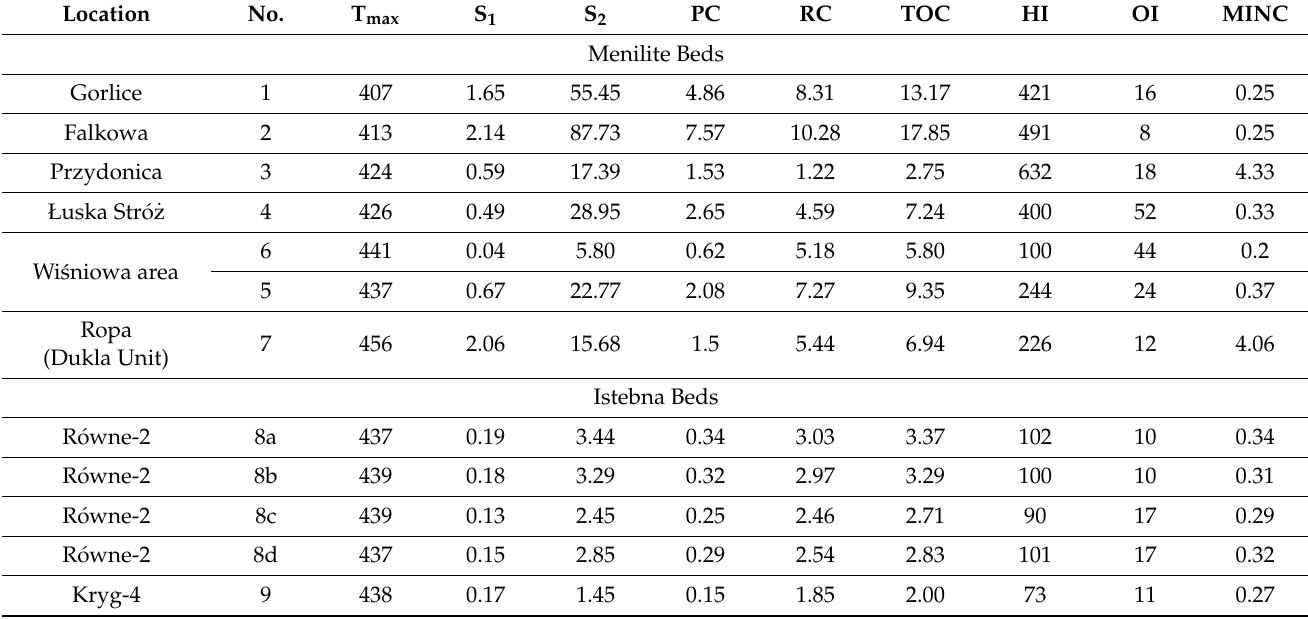
Table 1. Rock-Eval pyrolysis results